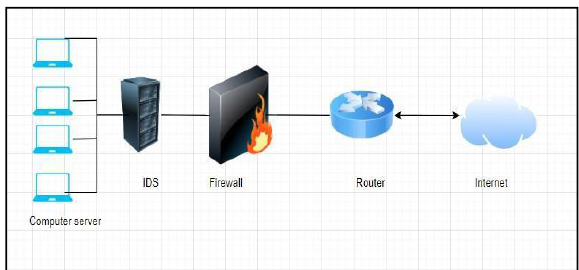
Figure 1. Typical Placement of an IDS within a